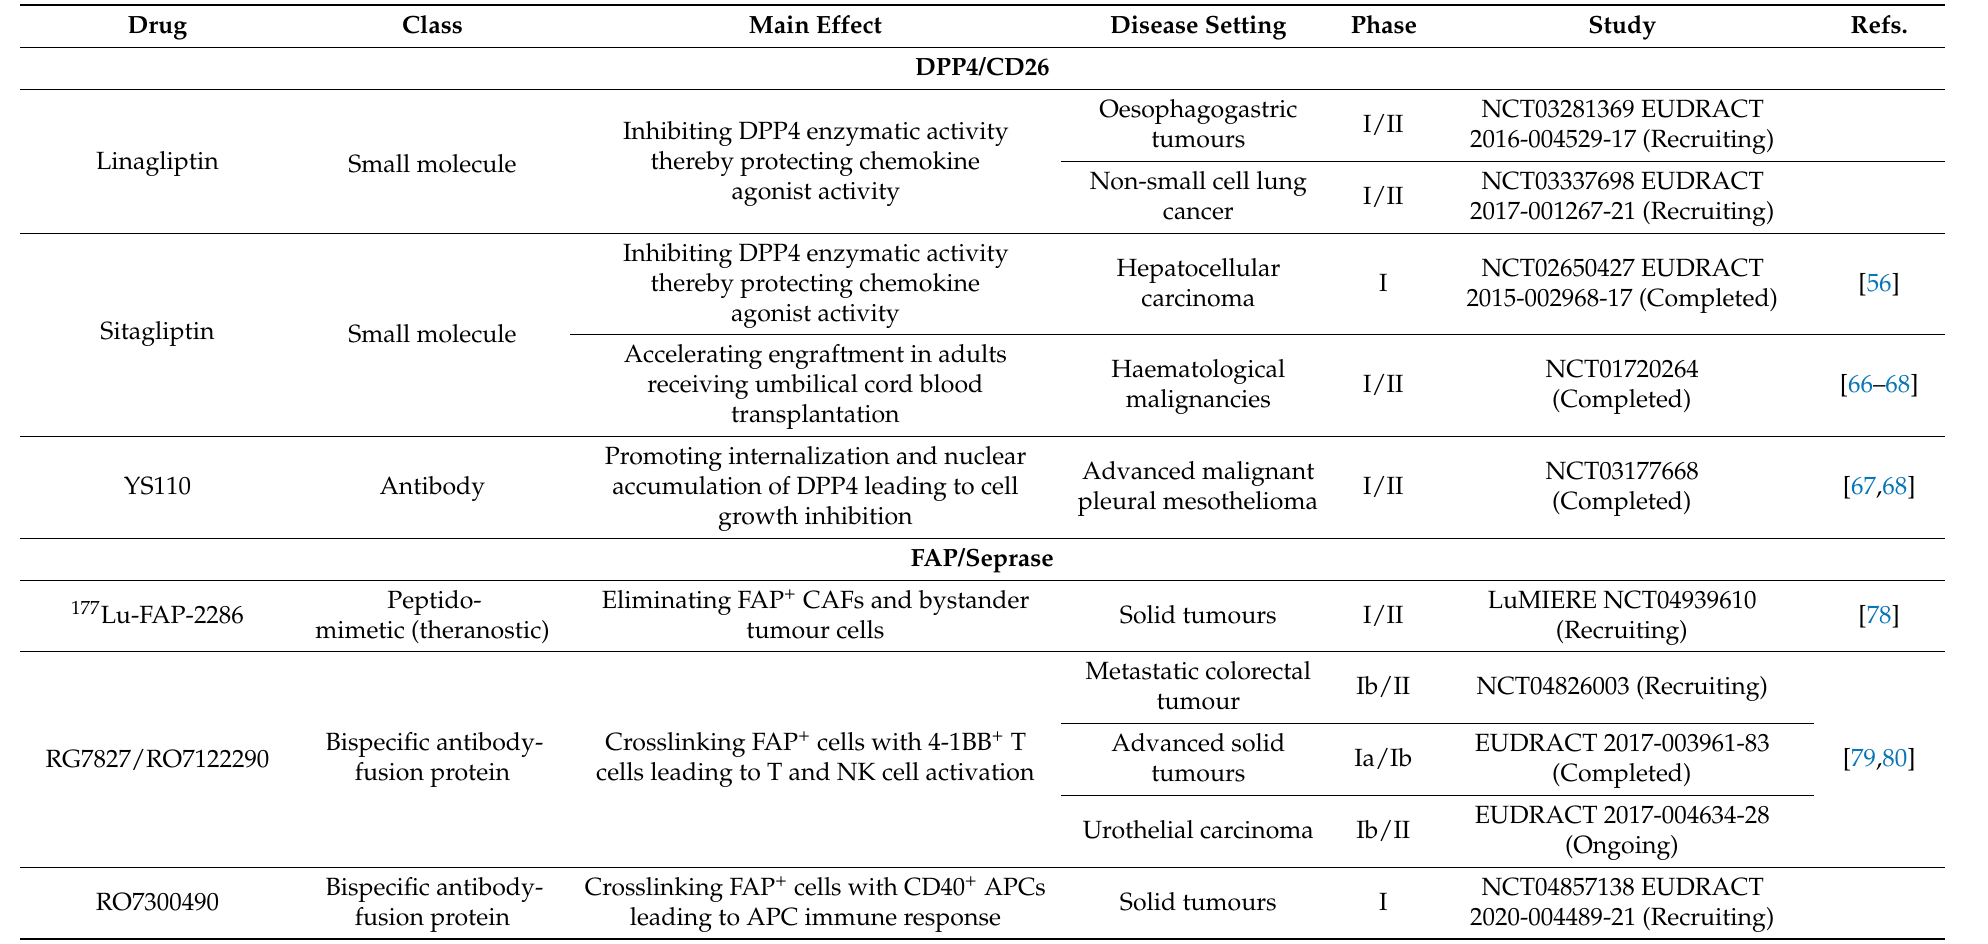
Table 1. Selected results of terminated, completed, ongoing, or recruiting clinical trials with drugs targeting cancer-associated